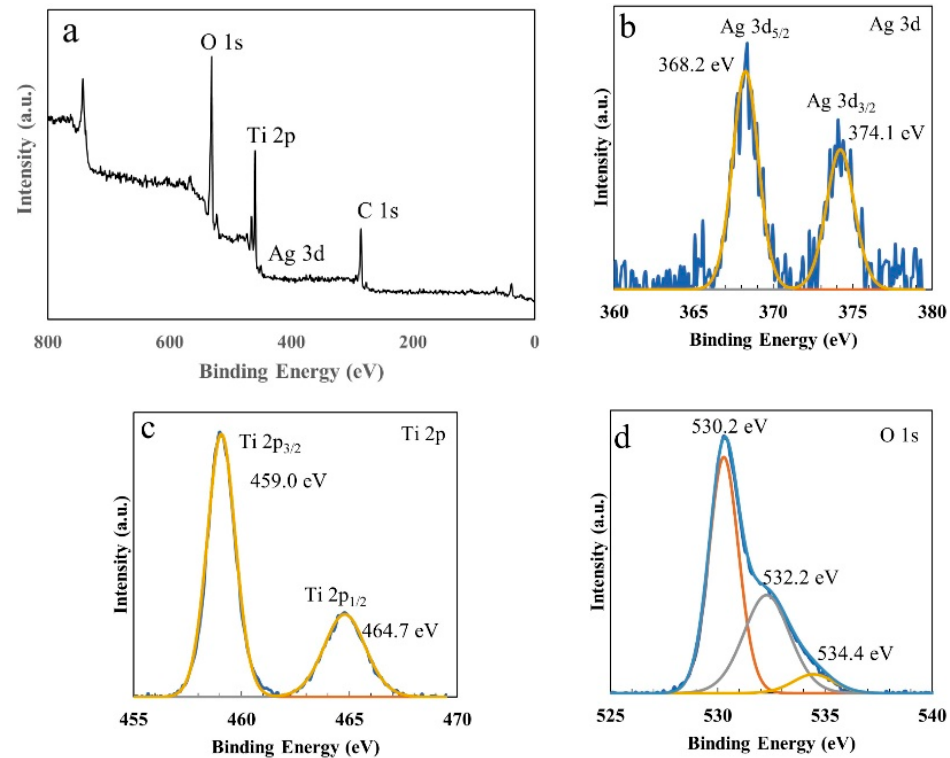
Figure 3. X-ray photoelectron profiles of the TiO 2 -Ag (1 wt%) film: ( a ) survey, ( b ) Ag 3d, ( c ) Ti 2p, Figure 3 . X-ray photoelectron profiles of the TiO 2 –Ag (1 wt%) film: ( a ) survey, ( b ) Ag3d, ( c ) Ti2p, and ( d ) O 1s and ( d ) O1s spectra.